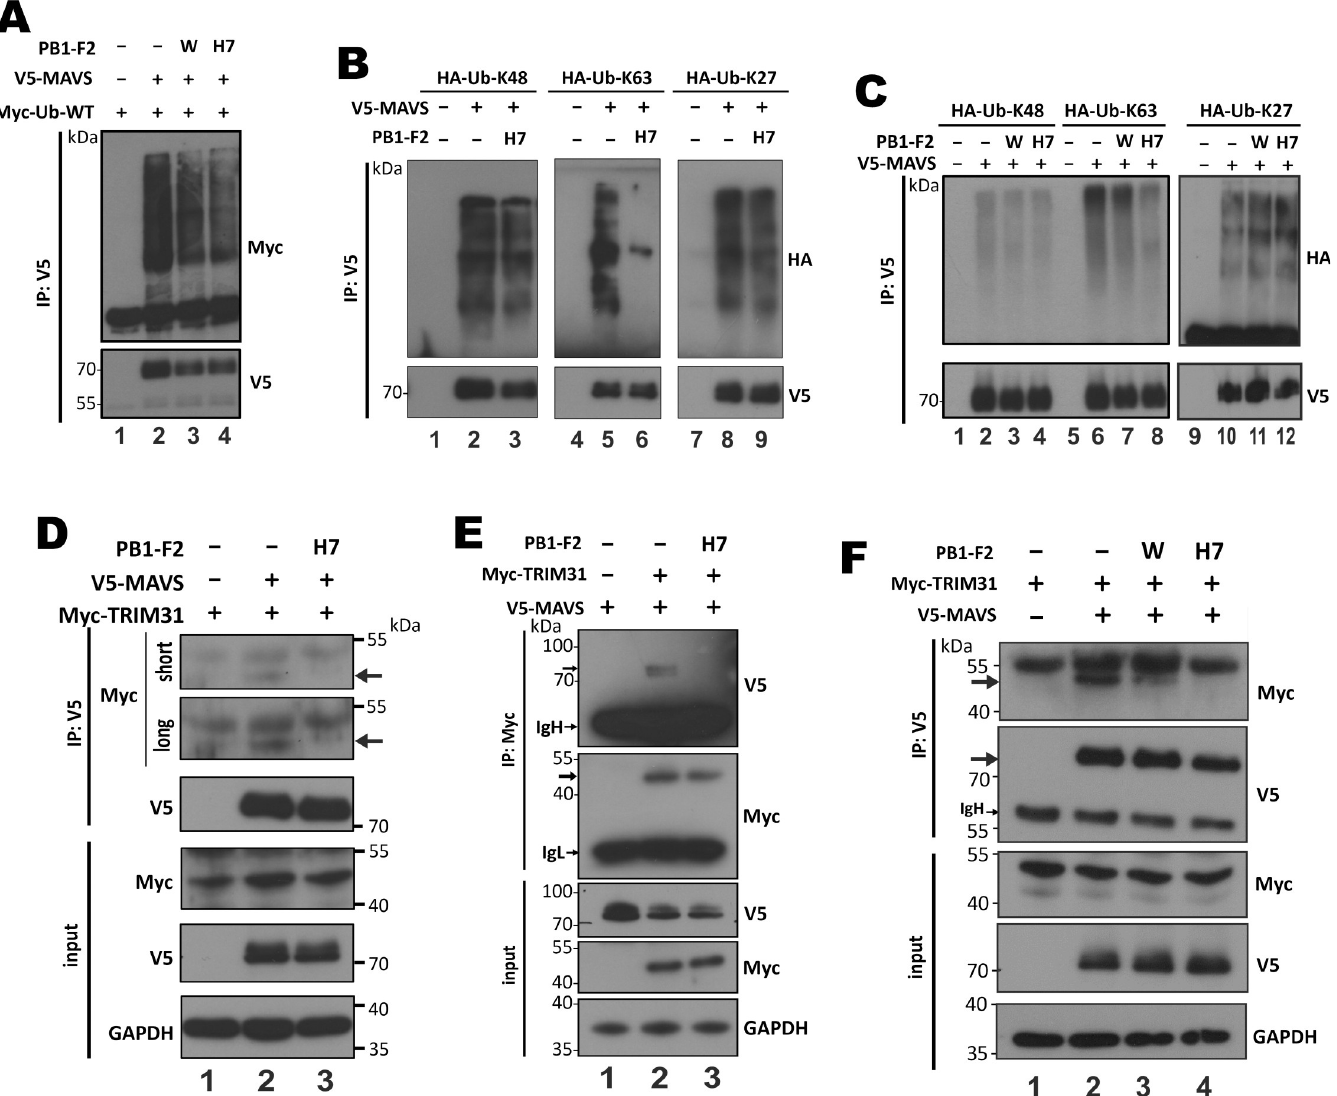
Fig 9. Suppression of TRIM31-mediated K63 polyubiquitination of MAVS by H7N9 PB1-F2. ( A ) HEK293T cells in 60mm dishes were transfected with 0.5 μ g expression construct for Myc-Ub-WT, 0.5 μ g pCAGEN-V5-MAVS and 0.25 μ g PB1-F2 expression construct. After 48 hours, cells were harvested for immunoprecipitation with anti-V5 (IP: V5). Immunoprecipitates were analyzed with SDS-PAGE and Western blot analysis with anti-Myc for ubiquitin chain and anti- V5 for MAVS. ( B ) HEK293T cells in 60mm dishes were transfected with 2 μ g expression construct for HA-Ub-mutants (K48, K63 or K27), 0.5 μ g pCAGEN-myc-MAVS and 0.25 μ g PB1-F2 expression construct. Immunoprecipitation and SDS-PAGE were performed as in (A). Western blot analysis was carried out with anti-HA for Ub mutant chains and anti-V5 for MAVS. ( C ) Same as in (B) except inclusion of WSN PB1-F2. ( D-F ) HEK293T cells in 60mm dishes were transfected with 2 μ g expression construct for myc-TRIM31, 0.2 μ g pCAGEN-myc-MAVS and 0.1 μ g PB1-F2 expression construct. After 48 hours, cells were harvested for co-immunoprecipitation with anti-V5 (D and F) or anti-Myc (E) as indicated (IP: V5 or IP: Myc). Both input and immunoprecipitates were analyzed by SDS-PAGE and Western blot analysis with anti-V5 for MAVS, anti-Myc for TRIM31 and anti-GAPDH for normalization. Arrows point to the target Myc-TRIM31 and V5-MAVS bands. Two exposures (long and short) of the same blot are presented in (D). IgH: immunoglobulin heavy chain. IgL: immunoglobulin light chain. Results were representative of three independent